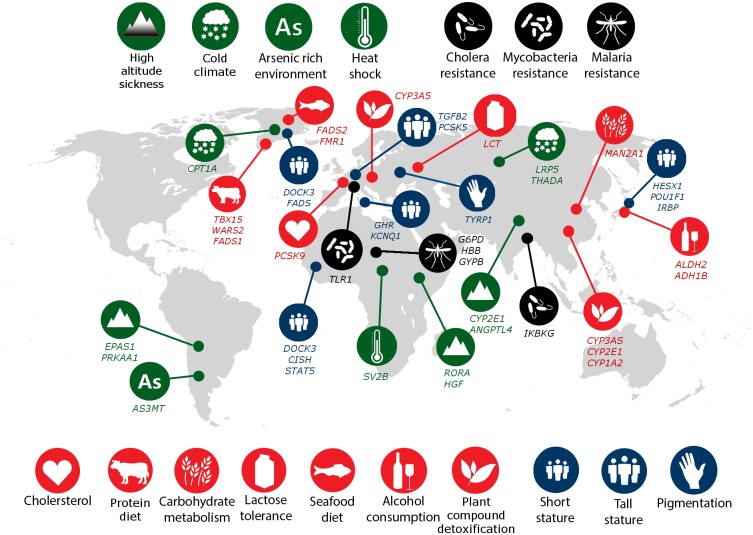
—Local human adaptations. Following Fan et al. (2016), each adaptation is labeled by the phenotype and/or selection pressure. The genetic loci under selection and the studied population are shown.